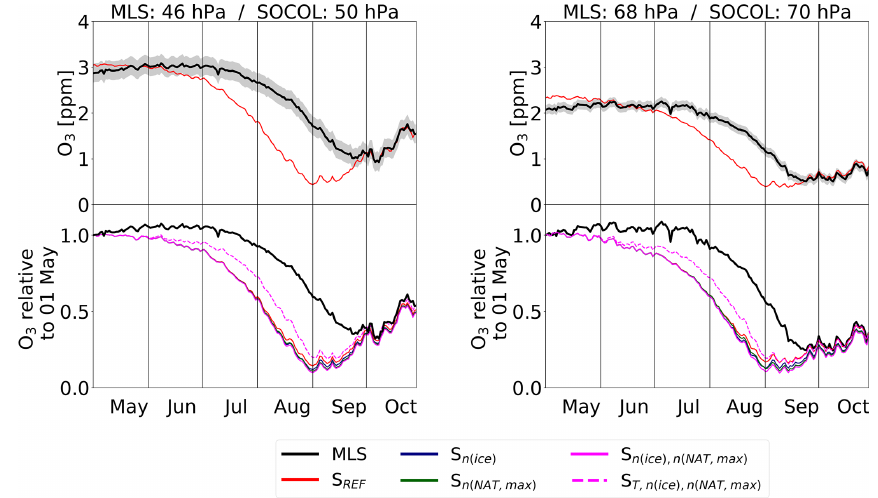
Figure A13. As Fig. 9, but for the year 2006.